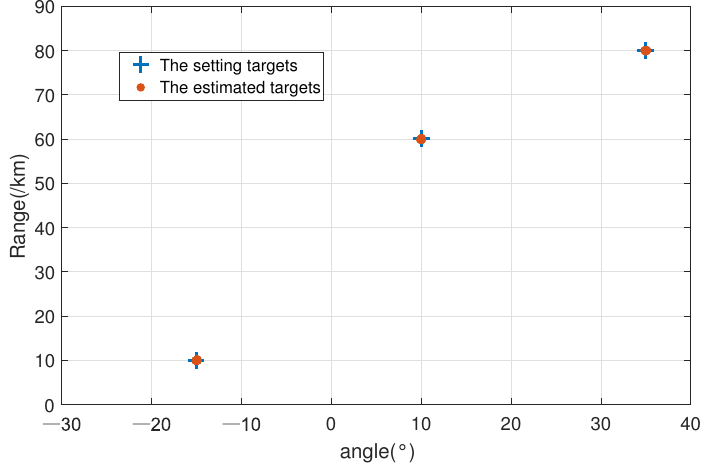
Figure 2. The calculated result of the method with J = 100, SNR = 20